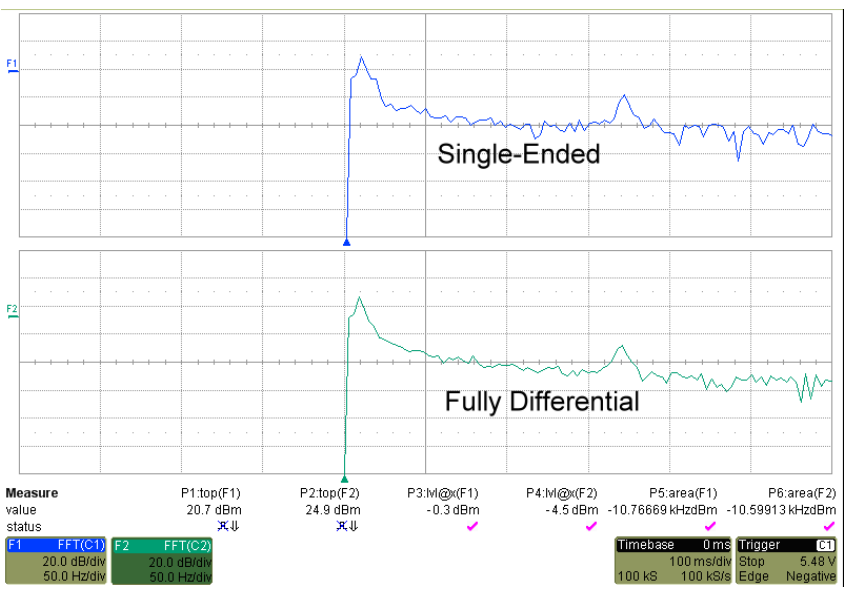
Figure 15. FFT analysis of SE and FD potentiostat.